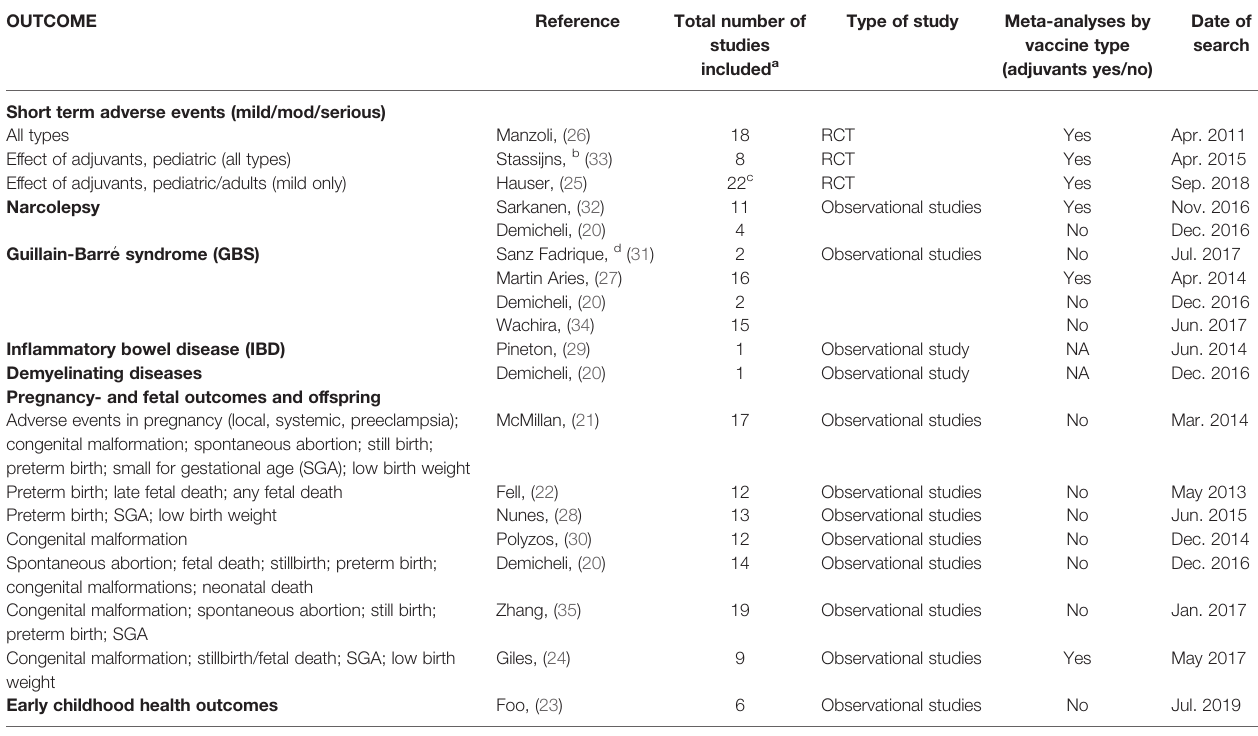
TABLE 3 | Overview of included systematic reviews on H1N1pdm09 vaccines according to